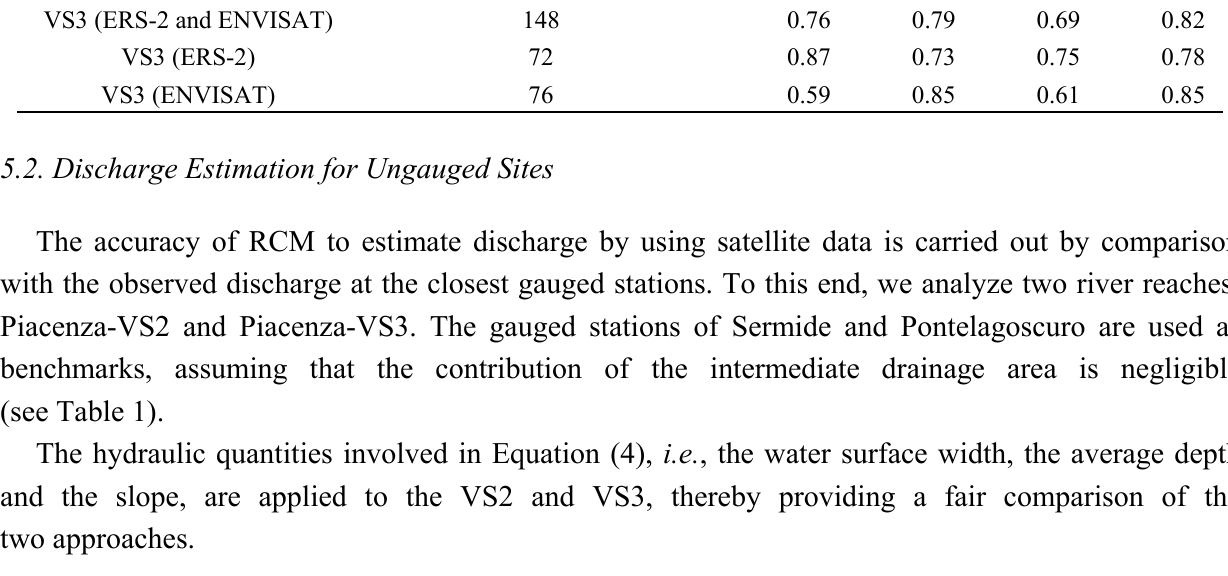
Table 4. Root mean square error (RMSE) and Nash Sutcliffe coefficient (NS) between the water levels measured at the in situ stations of Sermide and Pontelagoscuro and the water levels simulated by using regression relationships between satellite observations for VS2 and VS3 and in situ measurements. Number of Sermide Pontelagoscuro Satellite Altimetry Measurements RMSE (m) NS RMSE (m) NS VS2 (ERS-2) 72 0.80 0.63